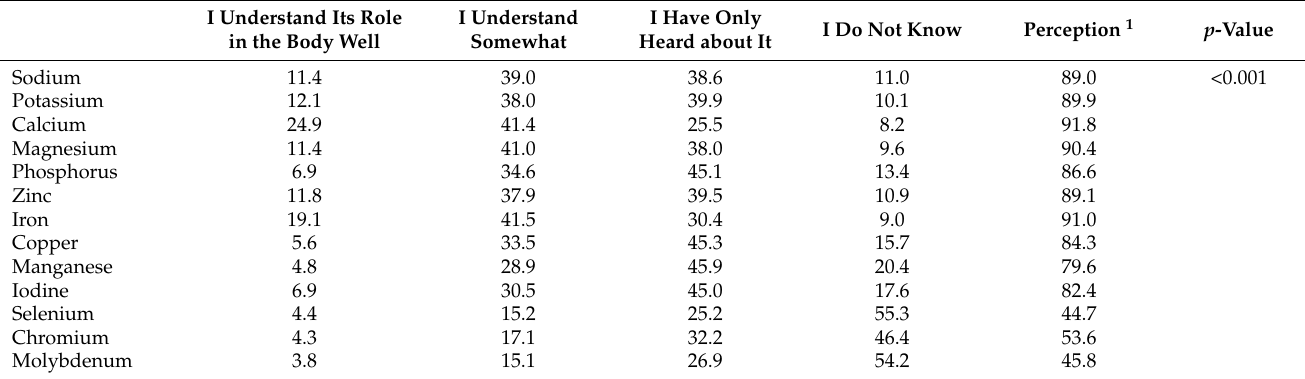
Table 7. The perception of each